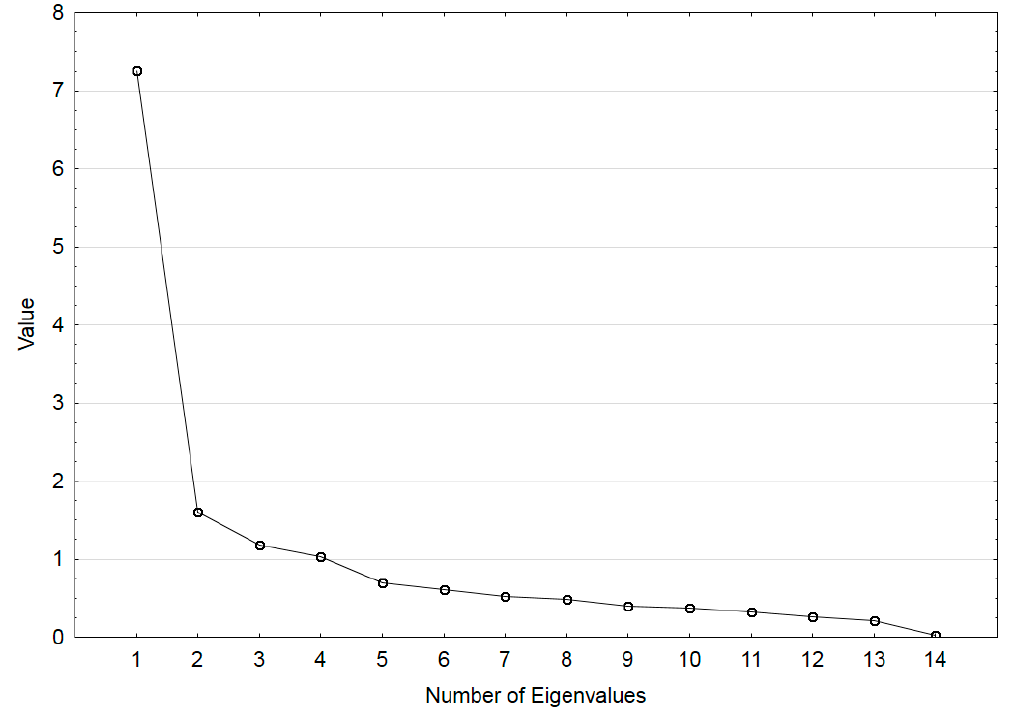
Figure 3. Scree plot for the BaHI items. Table 2. Factor loadings for each item of the BaHI in basketball players.